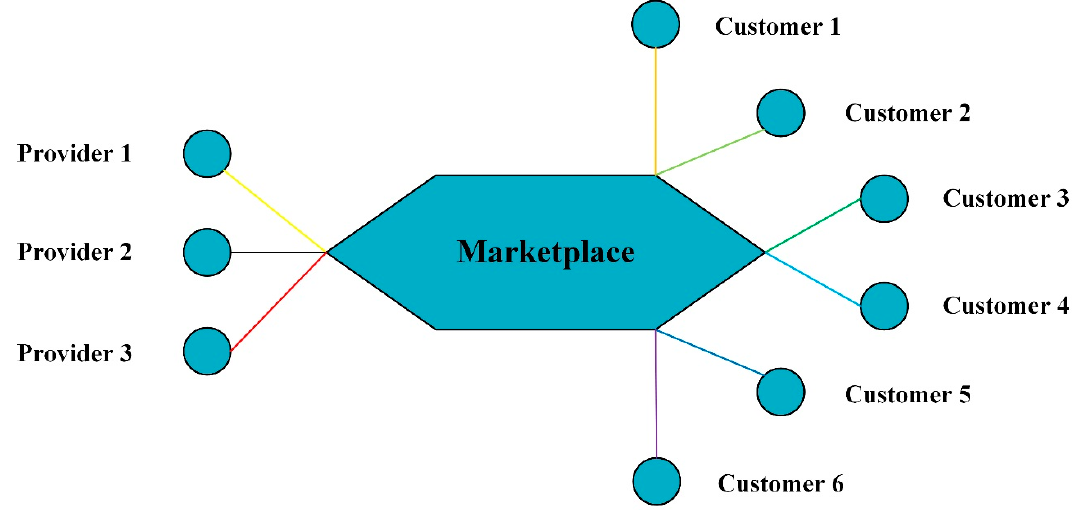
Figure 3. The simple topological structure of marketplace without using cloud center.